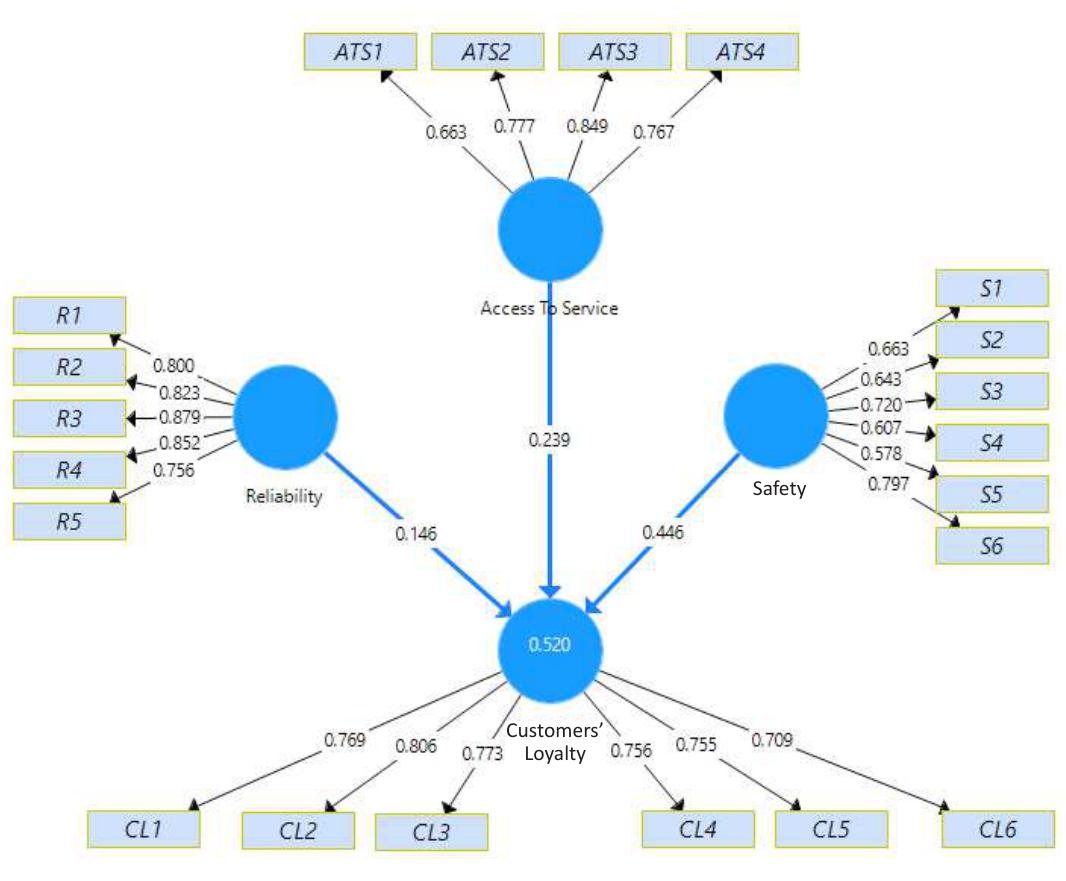
Figure 2. Confirmatory factor analysis